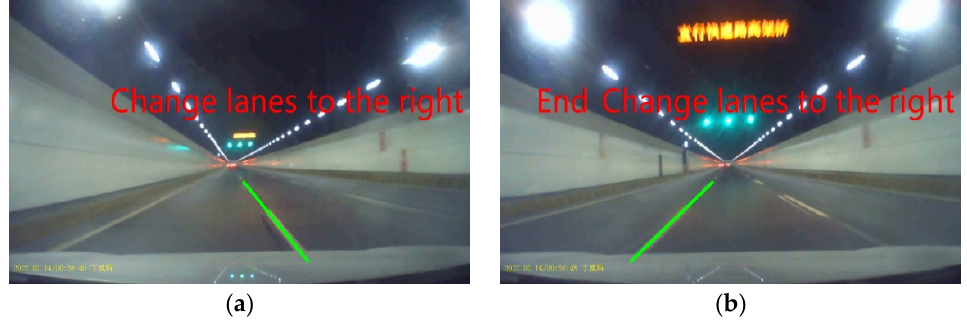
Figure 15. Images of the start and end moments of the vehicle lane change to the right: ( a ) Image of the start moment of the vehicle lane change to the right; ( b ) Image of the end moment of the vehicle lane change to the right.